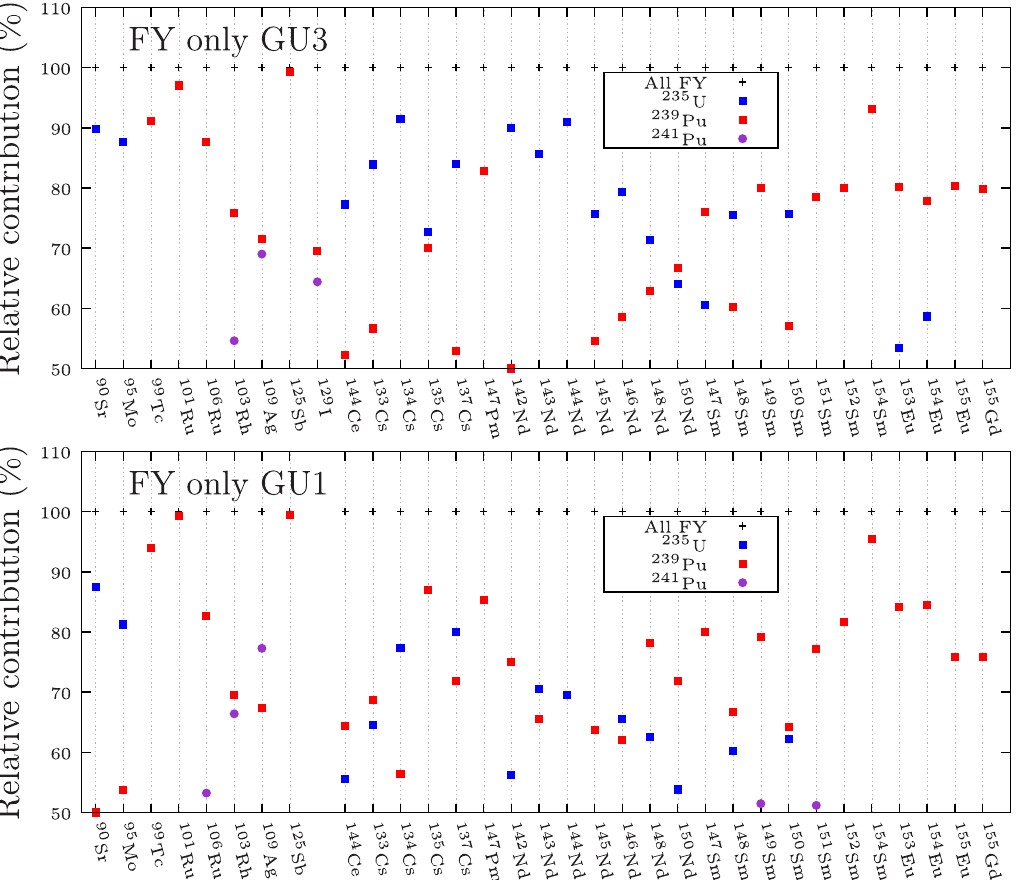
Fig. 6. Top: relative contributions of fission yields (called FY) to the total FY uncertainties for fission products of the GU3 sample. Bottom: same for the GU1 sample